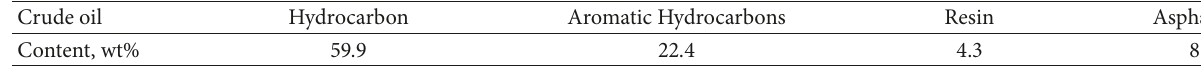
Table 2: Composition of crude oil.